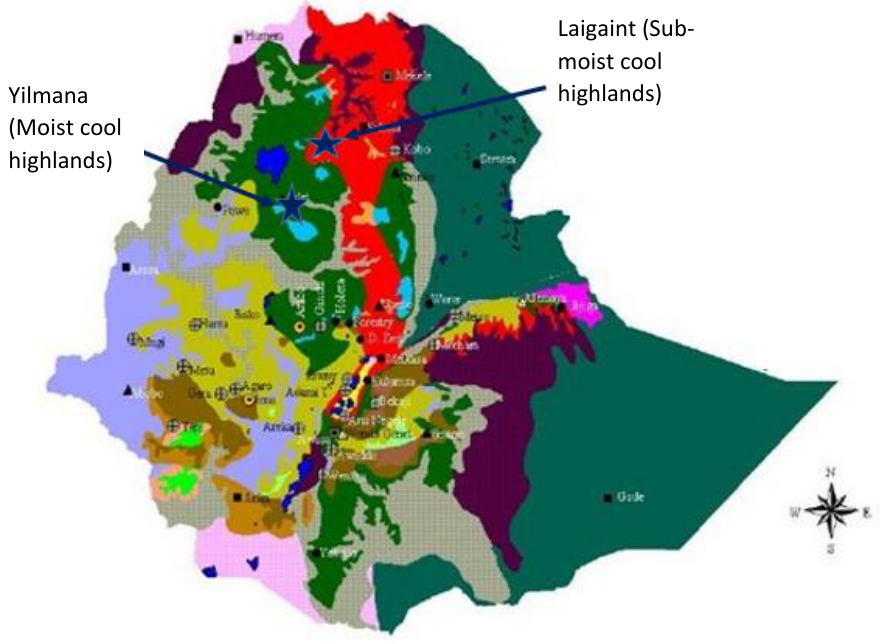
Fig 1. Study districts representing two major agroecological zones of Ethiopia for the PVS experiment in 2014